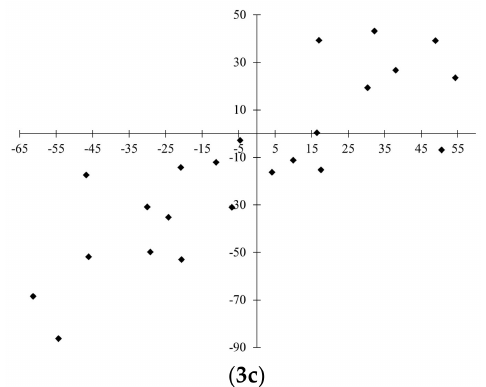
Figure 2. Observed-predicted diagrams for the developed models. Model 1: 1a —training in blue, validation in red; 1b —calibration; 1c —invisible training. Model 2: 2a —training in blue, validation in red; 2b —calibration; 2c —invisible training. Model 3: 3a —training in blue, validation in red; 3b —calibration; 3c —invisible training.